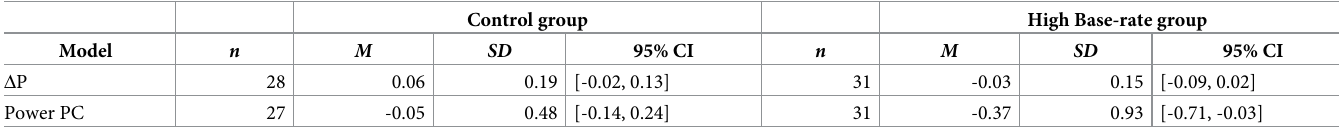
Table 2. Indexes obtained for the two models, Δ P and Power PC, computed from the actual training data in Experiment 1. The models cannot be computed for some participants (due to division by zero errors), so these cases are removed.